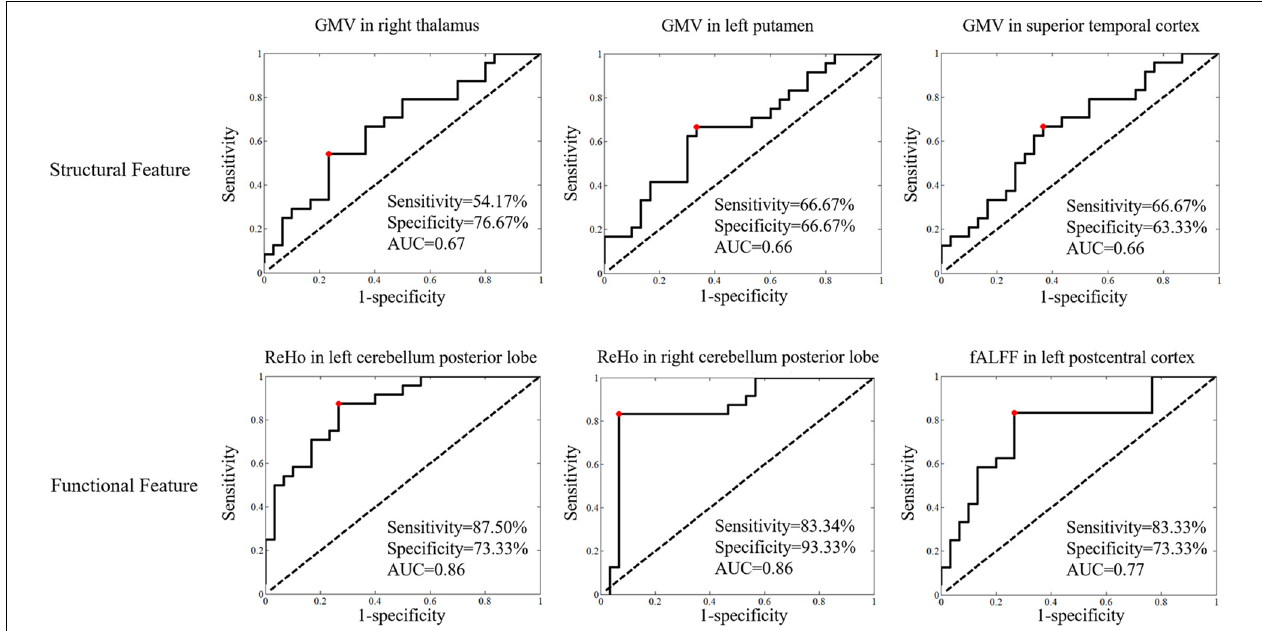
FIGURE 4 | The logistic regression analyses of the structural and functional features in statistically significant brain regions for discrimination of patients with NPSLE from those with non-NPSLE (features with the top 3 leading AUCs are presented). Classificational sensitivity, specificity and AUC are presented at the cut-off point (red). TABLE 5 | SVM classification results for the diagnosis of SLE from HCs and NPSLE from non-NPSLE using statistically significant structural and functional features selected by logistic regression with p < 0.005 and p < 0.001, respectively.